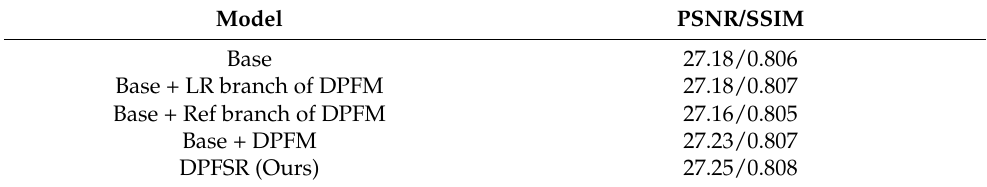
Table 2. Ablation study on the dual projection fusion module and deep channel attention connec- tion network.